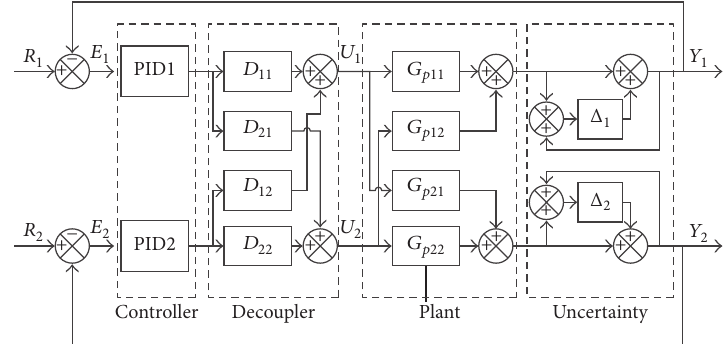
Figure 2: Control block diagram for decoupler design and robustness analysis.